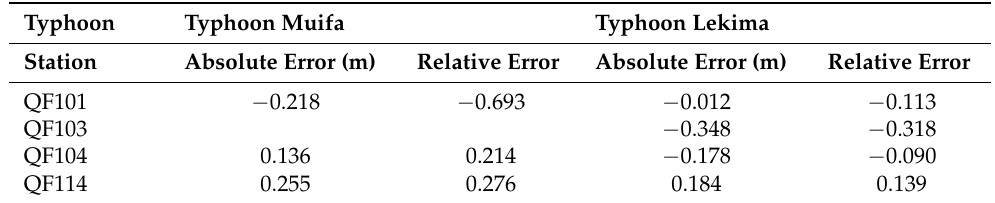
Table 5. The absolute error and relative error between the observed data and ERA5 reanalyzed data for a significant wave height at four stations (QF101, QF103, QF104, and QF114) during Typhoon Muifa and Typhoon Lekima. Significant digits are limited to three decimal places.